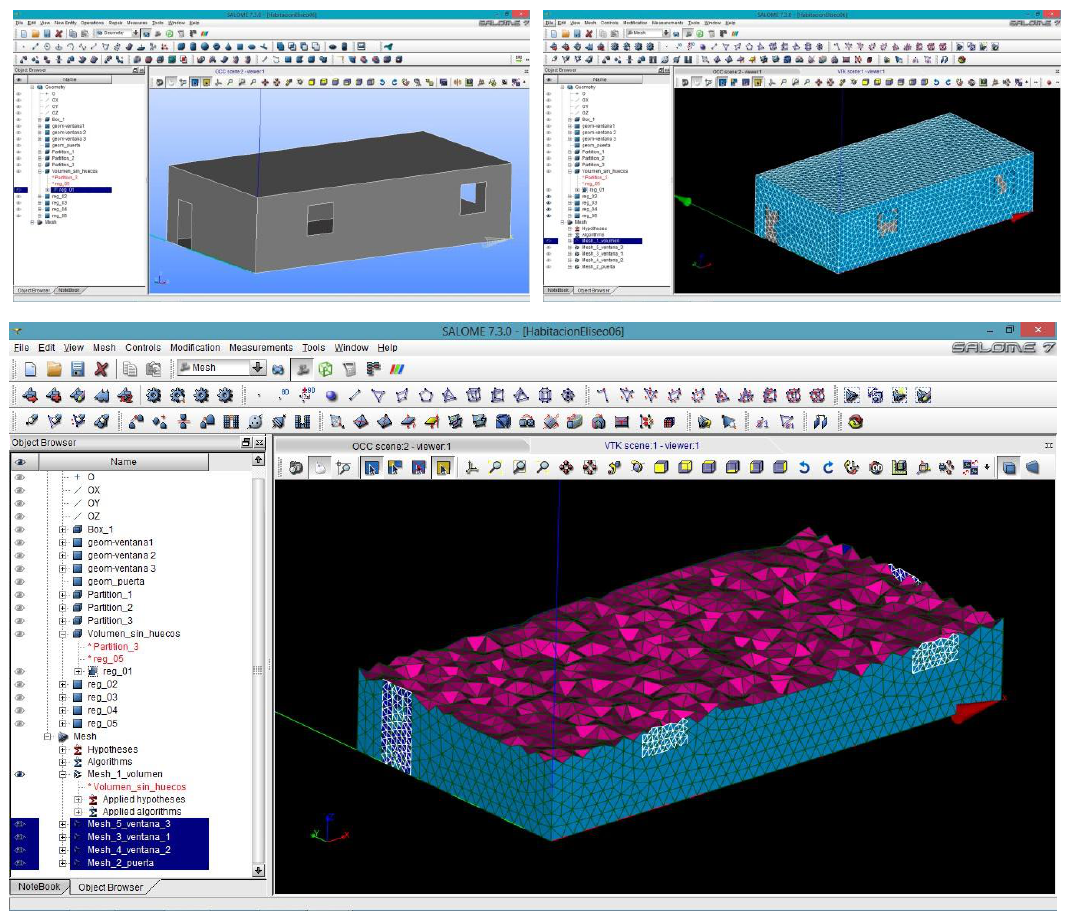
Figure 2. 3D geometries. An example from the current investigation.